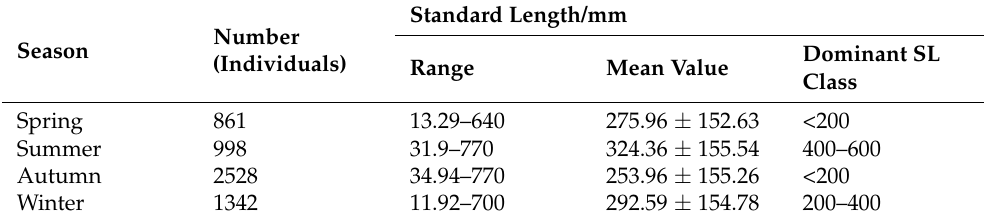
Table 4. Characteristics of fish distribution in different